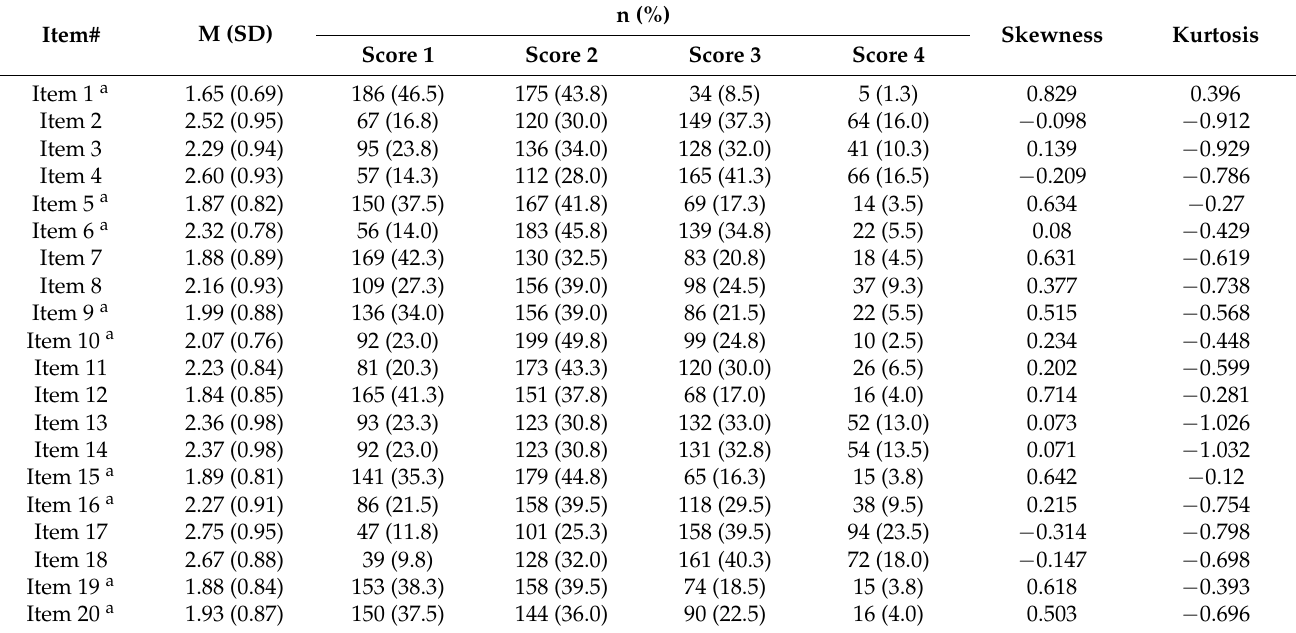
Table 2. Item properties of the UCLA Loneliness Scale (Version 3) (N =